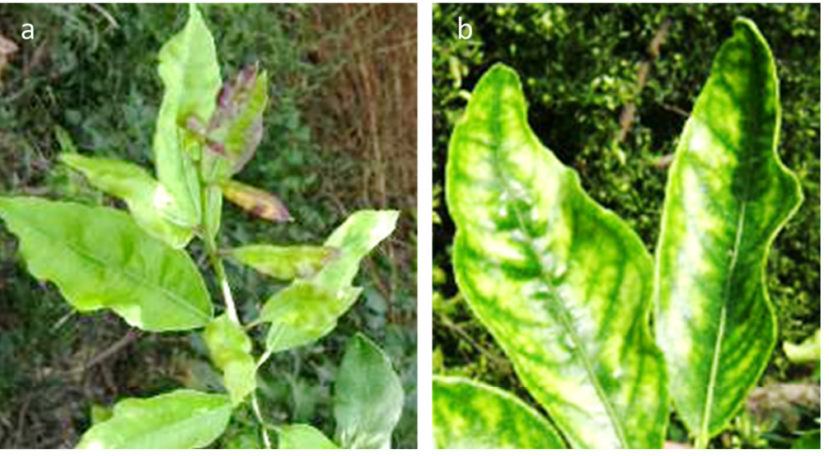
Figure 8. Indented margins of Interdonato lemon leaves ( a ), crinkling and chlorosis ( b ) in the Mersin region of Turkey (retrieved from the Ecoport slideshow, http://citrus.ecoport.org/, accessed on 31 July